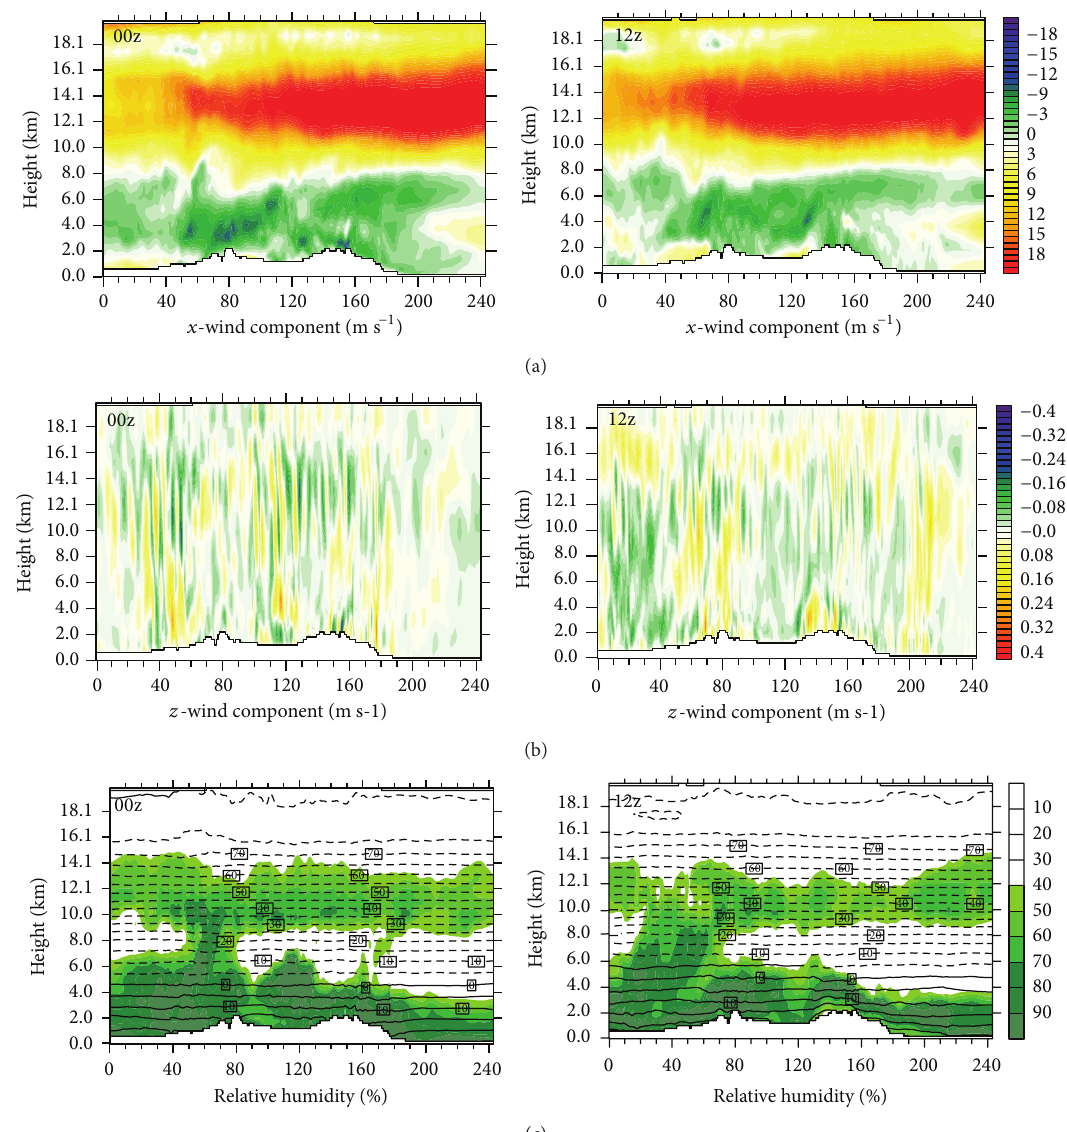
Figure 7: (a) Horizontal motion, (b) vertical motion, and (c) relative humidity at 00z and 12z on the November 22. The lake is situated in the center of the image, at approximately grid spaces